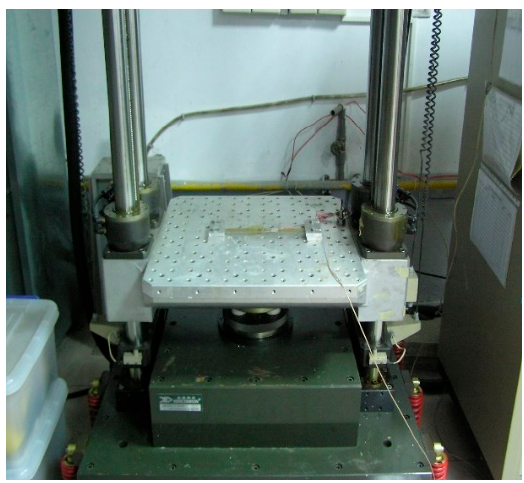
Figure 14. Free-fall drop table.